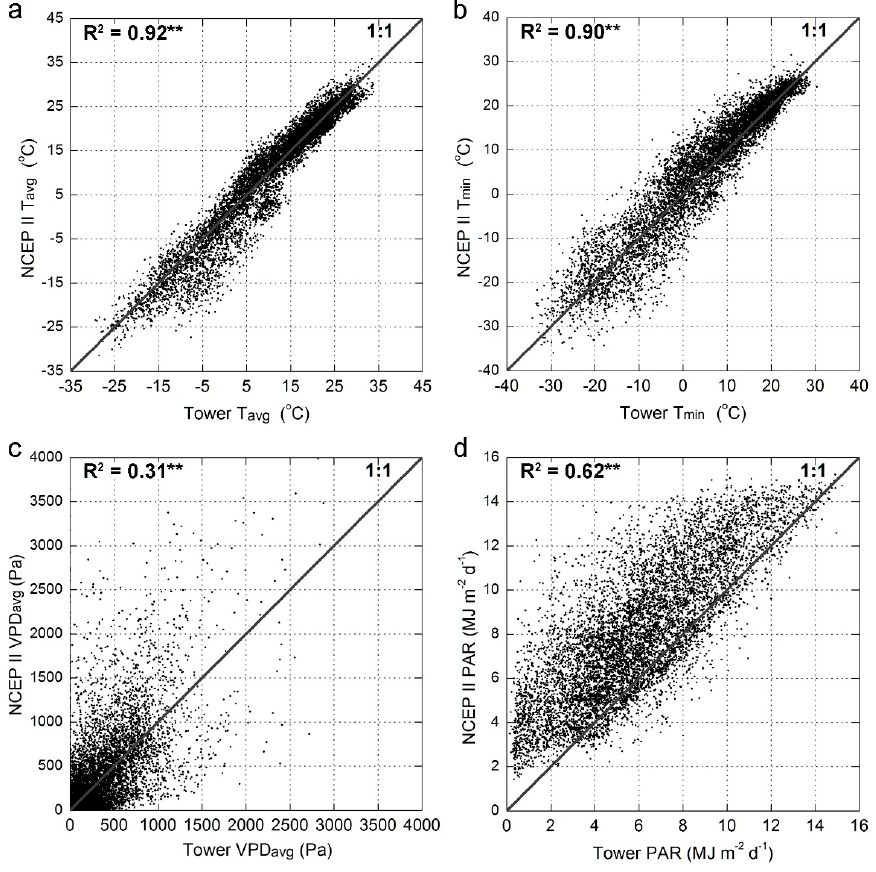
Figure 9. Scatterplots of the daily NCEP-DOE II meteorology against the daily tower meteorological data for: ( a ) T avg ; ( b ) T min ; ( c ) VPD avg ; and ( d ) PAR. Significance levels: ** p < 0.01.